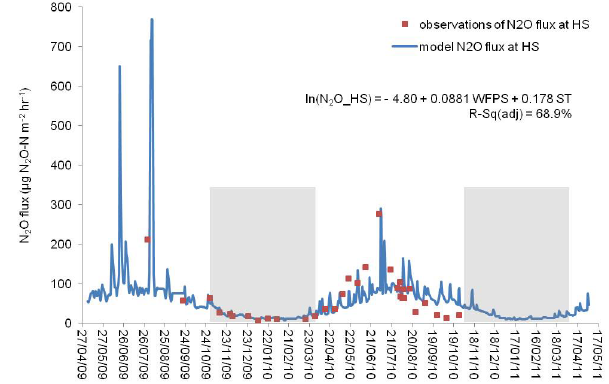
Fig. 9. Observed and simulated average N 2 O flux at hillslope (HS). The shaded area denotes the dry-cool